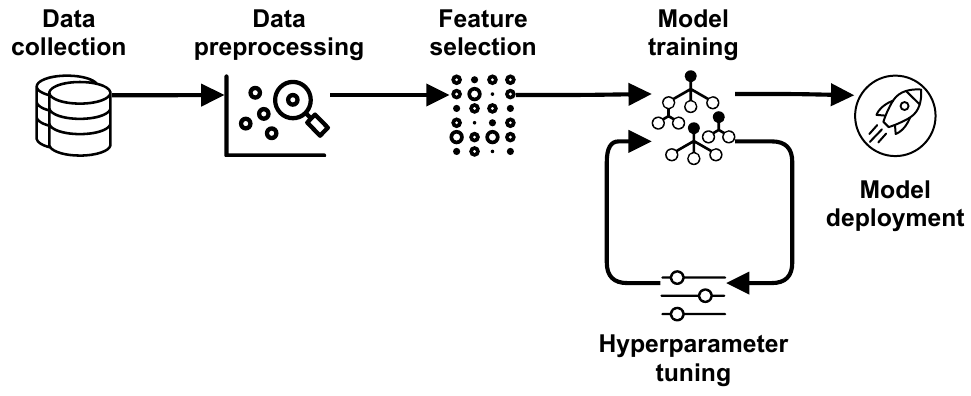
Figure 5. The pipeline of the model-centric ML